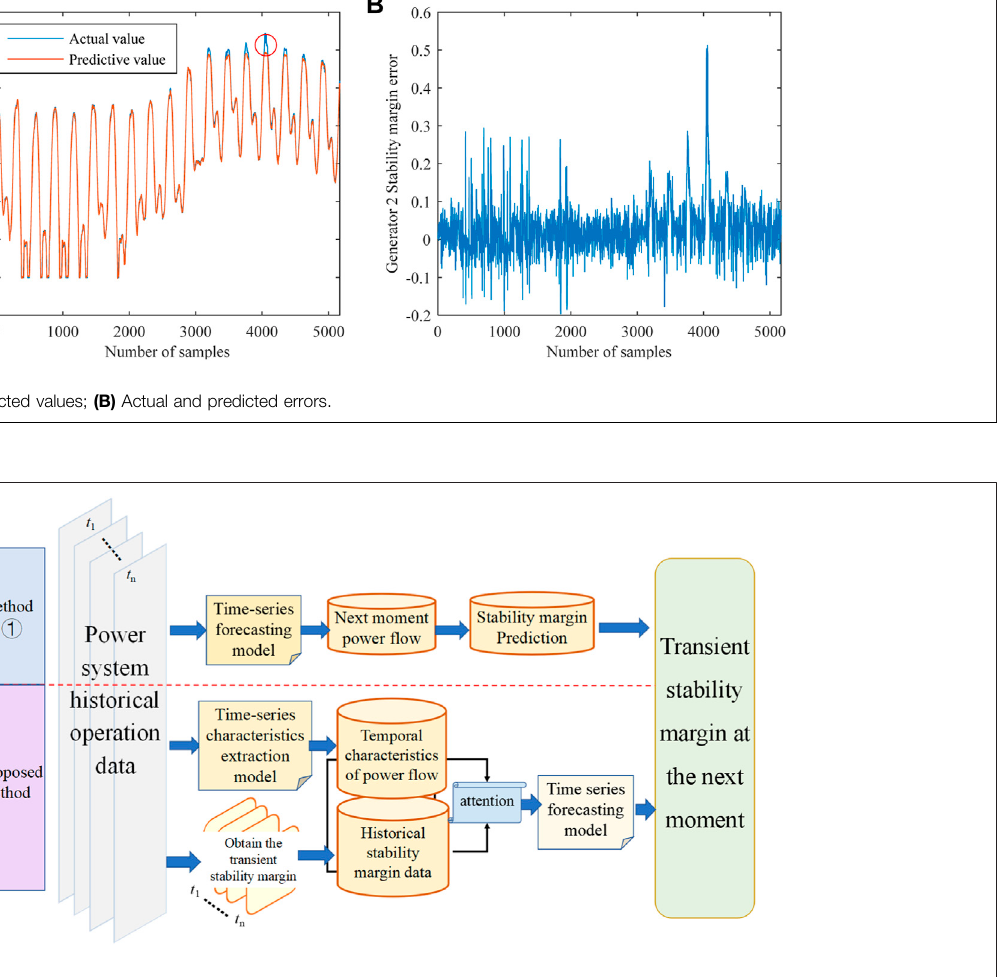
Figure 5B . Figure 5 illustrates that the predicted stability margin is close to the actual value based on the model trained using the sample data. The red circle in Figure 5A shows the maximum value of the absolute error occurring on the curve, which is 0.5127. The corresponding relative error is 8.0%, thus indicating adequate prediction characteristics.